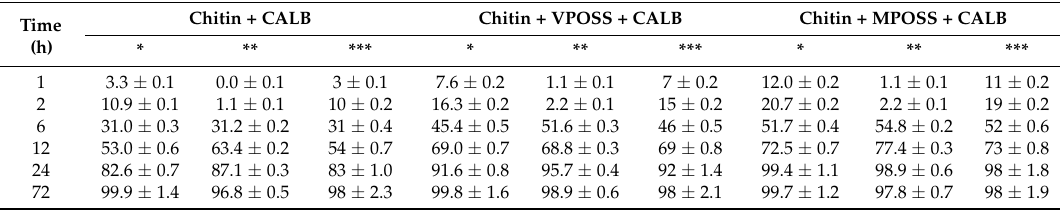
Table 5. Effect of the reaction time on the chemical composition, * relative content of FAME (%), ** relative content of glycerol (% w / w ), and *** conversion (%) after methanolysis of rapeseed oil. As the relative content, the measured mass of the substance to theoretical mass of the substance after total methanolysis is considered. Reaction conditions: 7.5 cm 3 rapeseed oil, 1.5 cm 3 methanol, 10 mg of the immobilized lipase, pH 10, T = 40 ◦